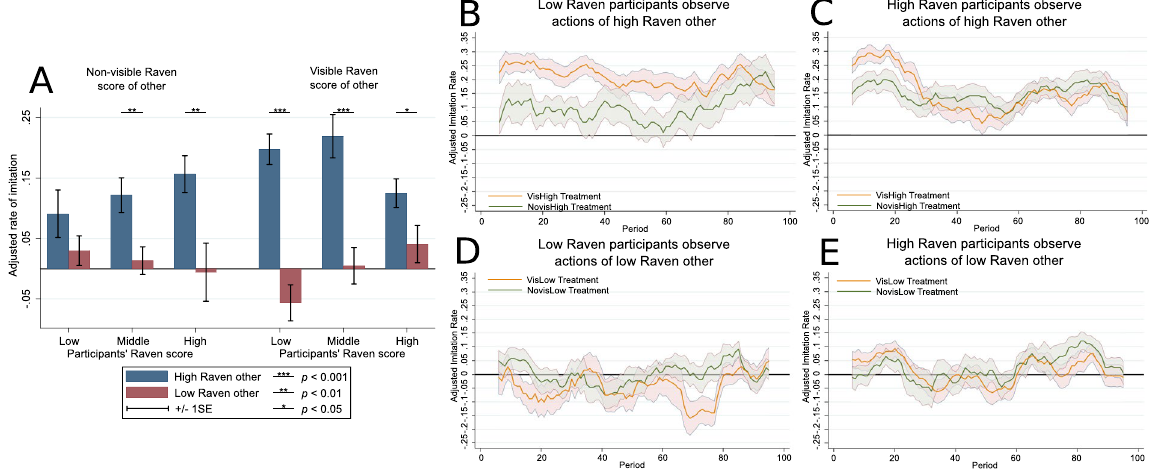
Figure 2. Adjusted imitation rate in Experiment 2. ( A ) The adjusted rate of imitation by the terciles of the Raven score of the participants in treatments with a non-visible and visible Raven score of the other. Blue (red) bars represent the adjusted rate of imitation in treatments in which participants observed the high (low) Raven other. The p -values (from left to right: 0.003, 0.004, < 0.001, < 0.001, 0.033) denote the significance of the t -tests on the differences in coefficients of an ordinary least squares (OLS) regression that the bars represent (first column of Table 4 in Appendix B.2). ( B ) The dynamics of the running average of the adjusted imitation rate of low Raven participants (below median Raven score) when they observe a high Raven other (only for 100 periods when the action of the other is observed). Ranges are ± 1 SE. ( C ) Same as B only for high Raven participants (above median Raven score). ( D , E ) Analogous graphs for the situation when the low Raven other is